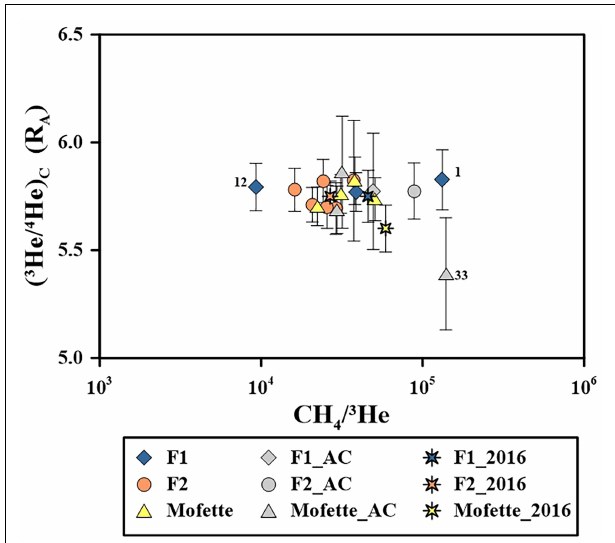
FIGURE 6 | Air-corrected ( 3 He/ 4 He) c vs. CH 4 / 3 He diagram (cf. Poreda et al., 1988). The abbreviation _AC stands for air contamination, while data of samples collected during 2016 are from Bräuer et al. (2018).